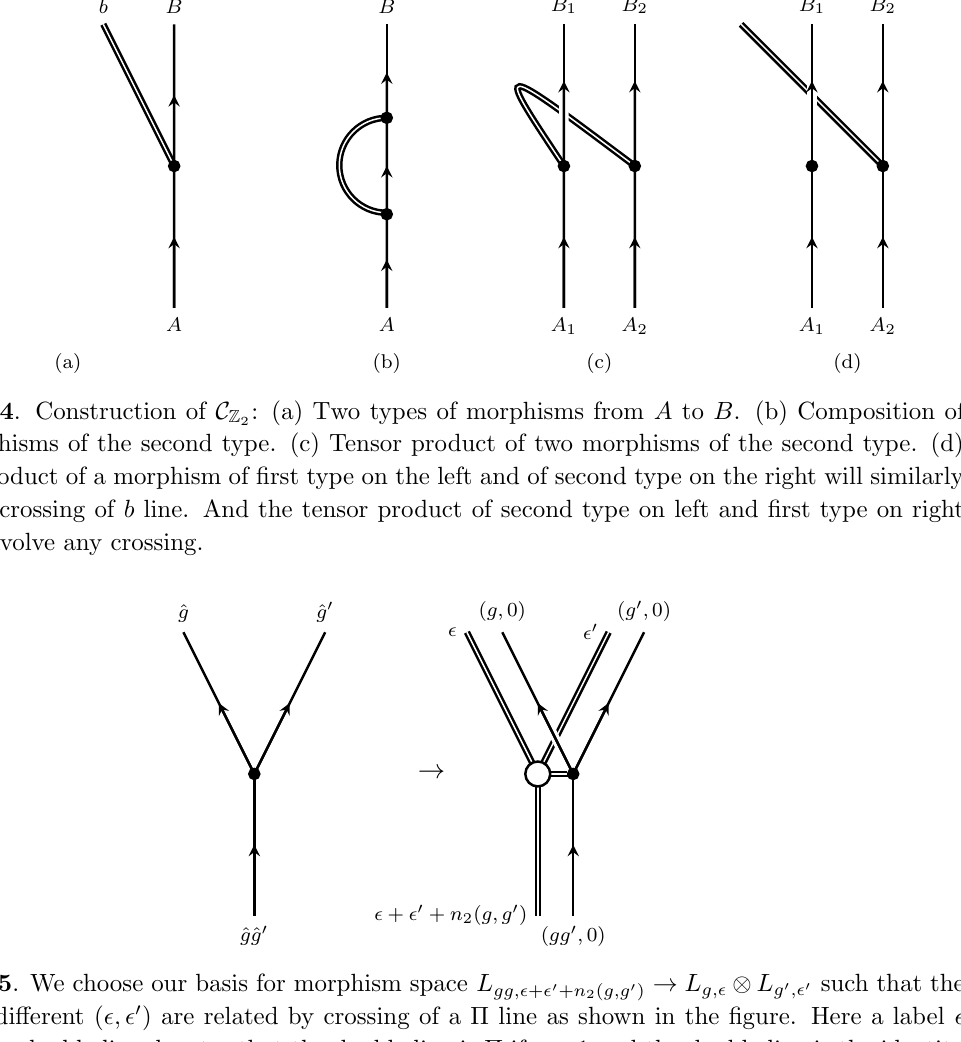
! L g;(cid:15) (cid:10) L g 0 ;(cid:15) 0 such that the gg;(cid:15) + (cid:15) 0 + n 2 ( g;g 0 )